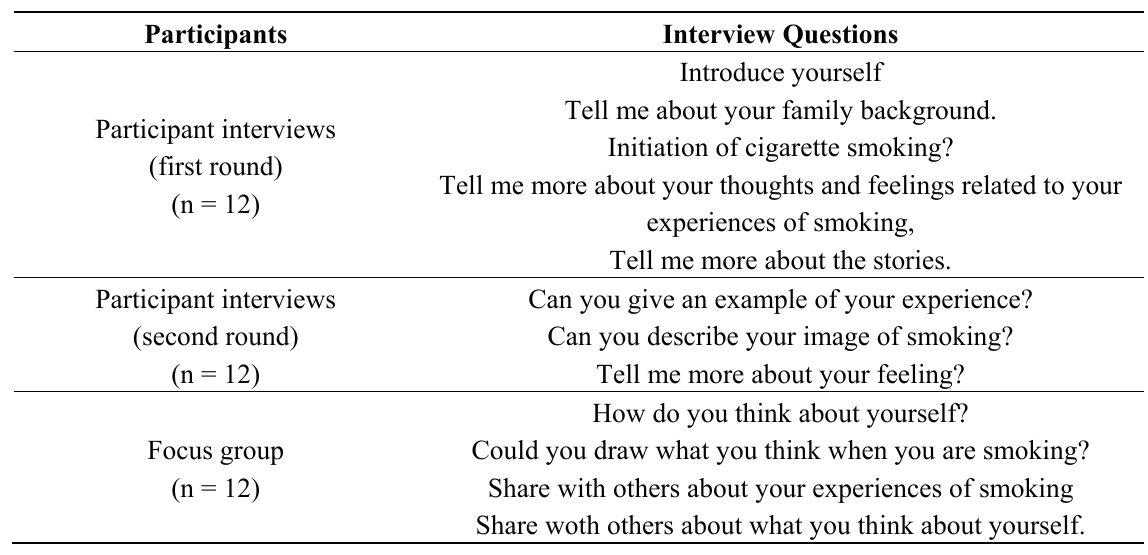
Table 1. The flow of the topics used during the